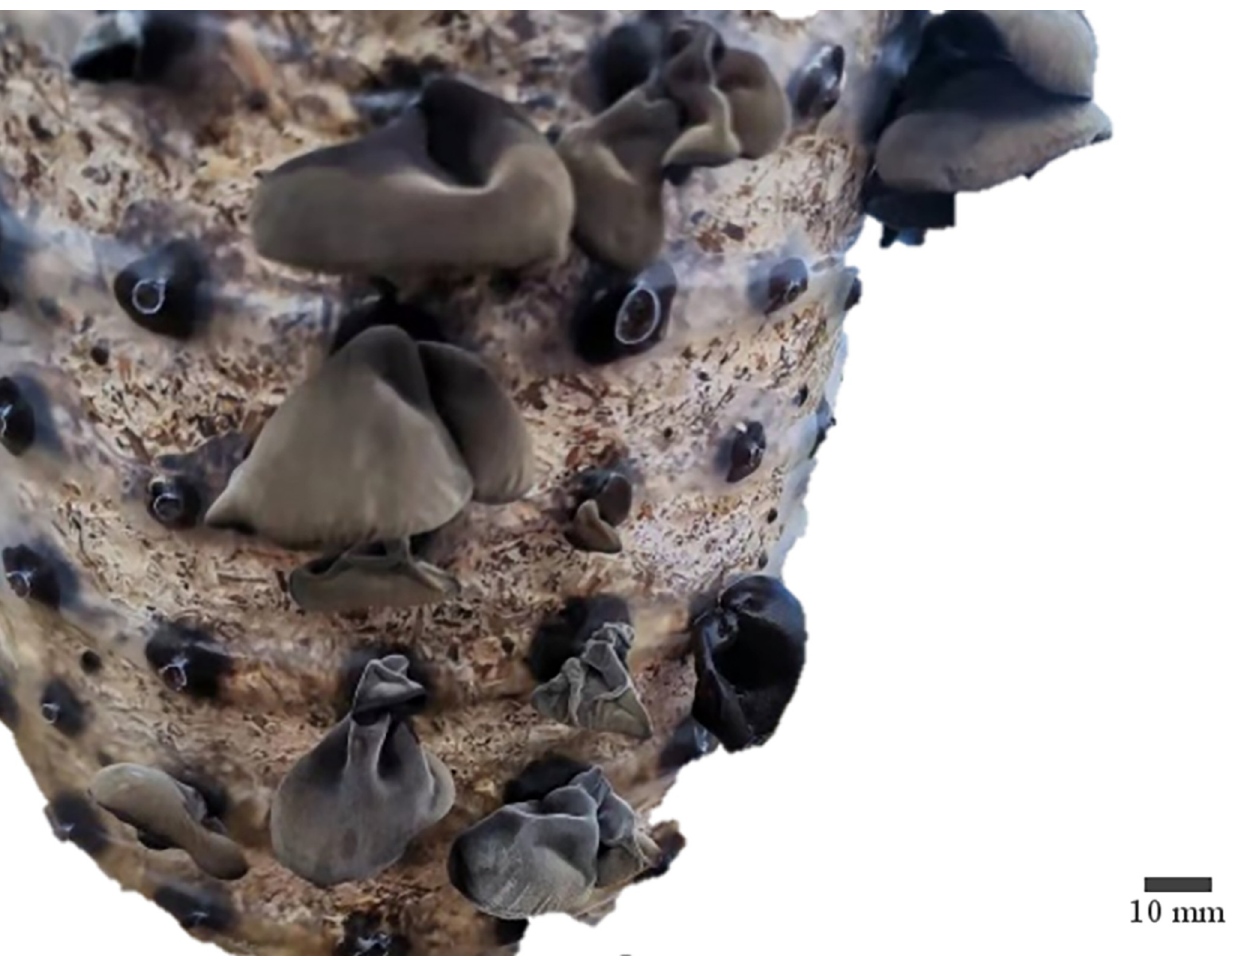
Fig 2. Physical picture of black fungus. rated load is 5KN and the error is within 0.5%. The displacement resolution is 0.01mm and the loading rate is 0.01~300mm/min. The force, displacement, and other parameters during the test can be automatically recorded by the software that comes with it. In the mono-factor separation force test of black fungus, the black fungus sticks to be picked were selected and marked with a marker. And the sticks were fixed on the test machine fixture using the self-locking nylon tie. The black fungus leaves were clamped using a pair of strong magnets, which were connected to the universal material testing machine through a non-elastic rope, as shown in Fig 4. To simplify the test analysis, the four influencing factors of black fungus height, loading rate, tension angle, and moisture content were labeled as A, B, C, and D. Five replicate tests were conducted at each level, and the test results are shown in Tables 1–5. Immediately after the separation force measurement, the moisture content was measured. In the experiment on the effect of black fungus height on separation force, black fungus height was the vertical distance from the top of the black fungus leaf to the fungus stick. According to the growth of black fungus and the relevant harvesting standards [22], we divided the black fungus height (A) into three intervals: 0–25 mm immature black fungus (A ), 25 mm to 40 mm mature black fungus (A ), and over-mature black fungus above 40 mm 1 2